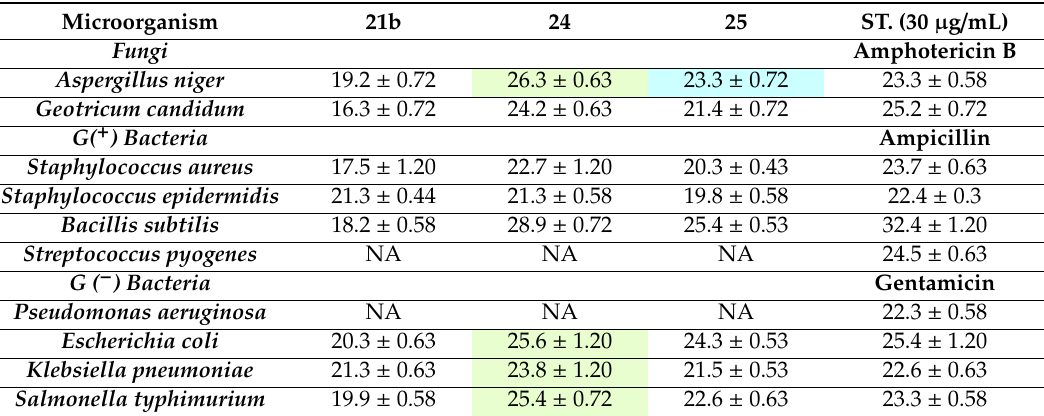
Table 6. Preliminary anti-microbial activity for compounds 21b , 24 and 25 . Table 5. Preliminary anti-microbial activity for compounds 19c – f and 21a . Table 3. Preliminary anti-microbial activity for compounds 2 , 6 – 8 , 12 .